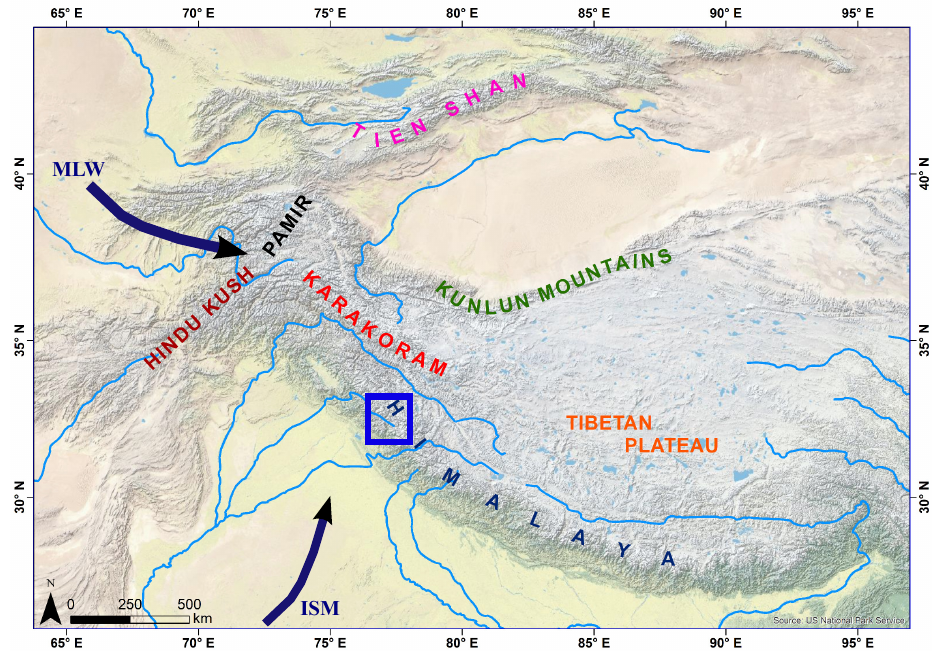
Figure 1. Map of the mountain ranges of high-mountain Asia showing the major rivers (light blue polylines) and two wind systems (MLW and ISM). The blue rectangle represents the study region